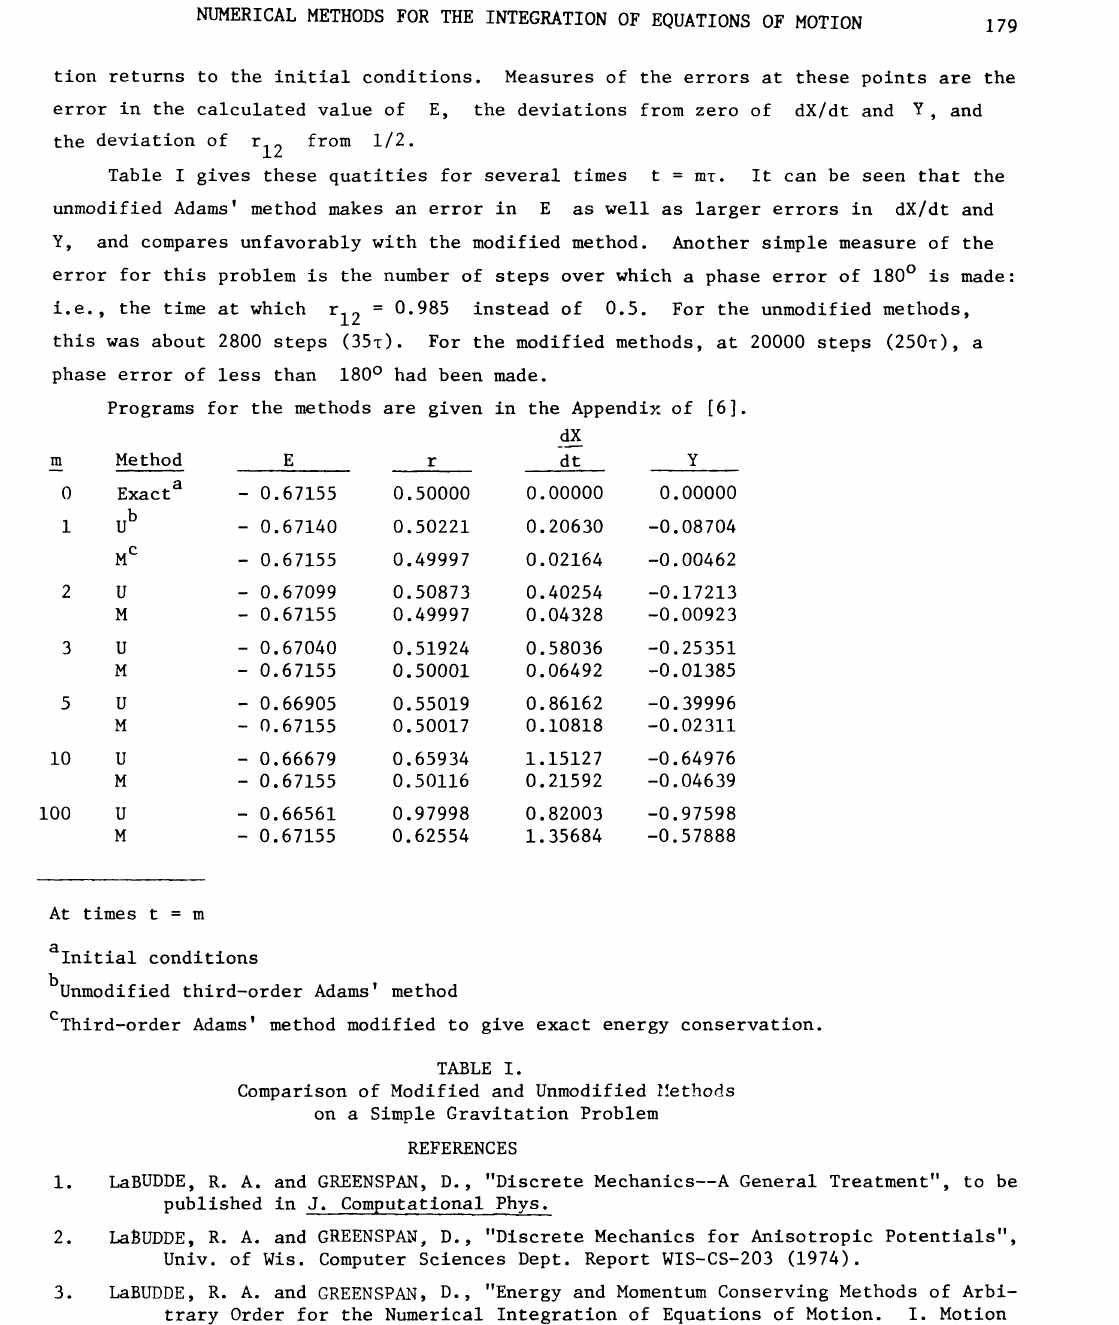
TABLE I. Comparison of Modified and Unmodified